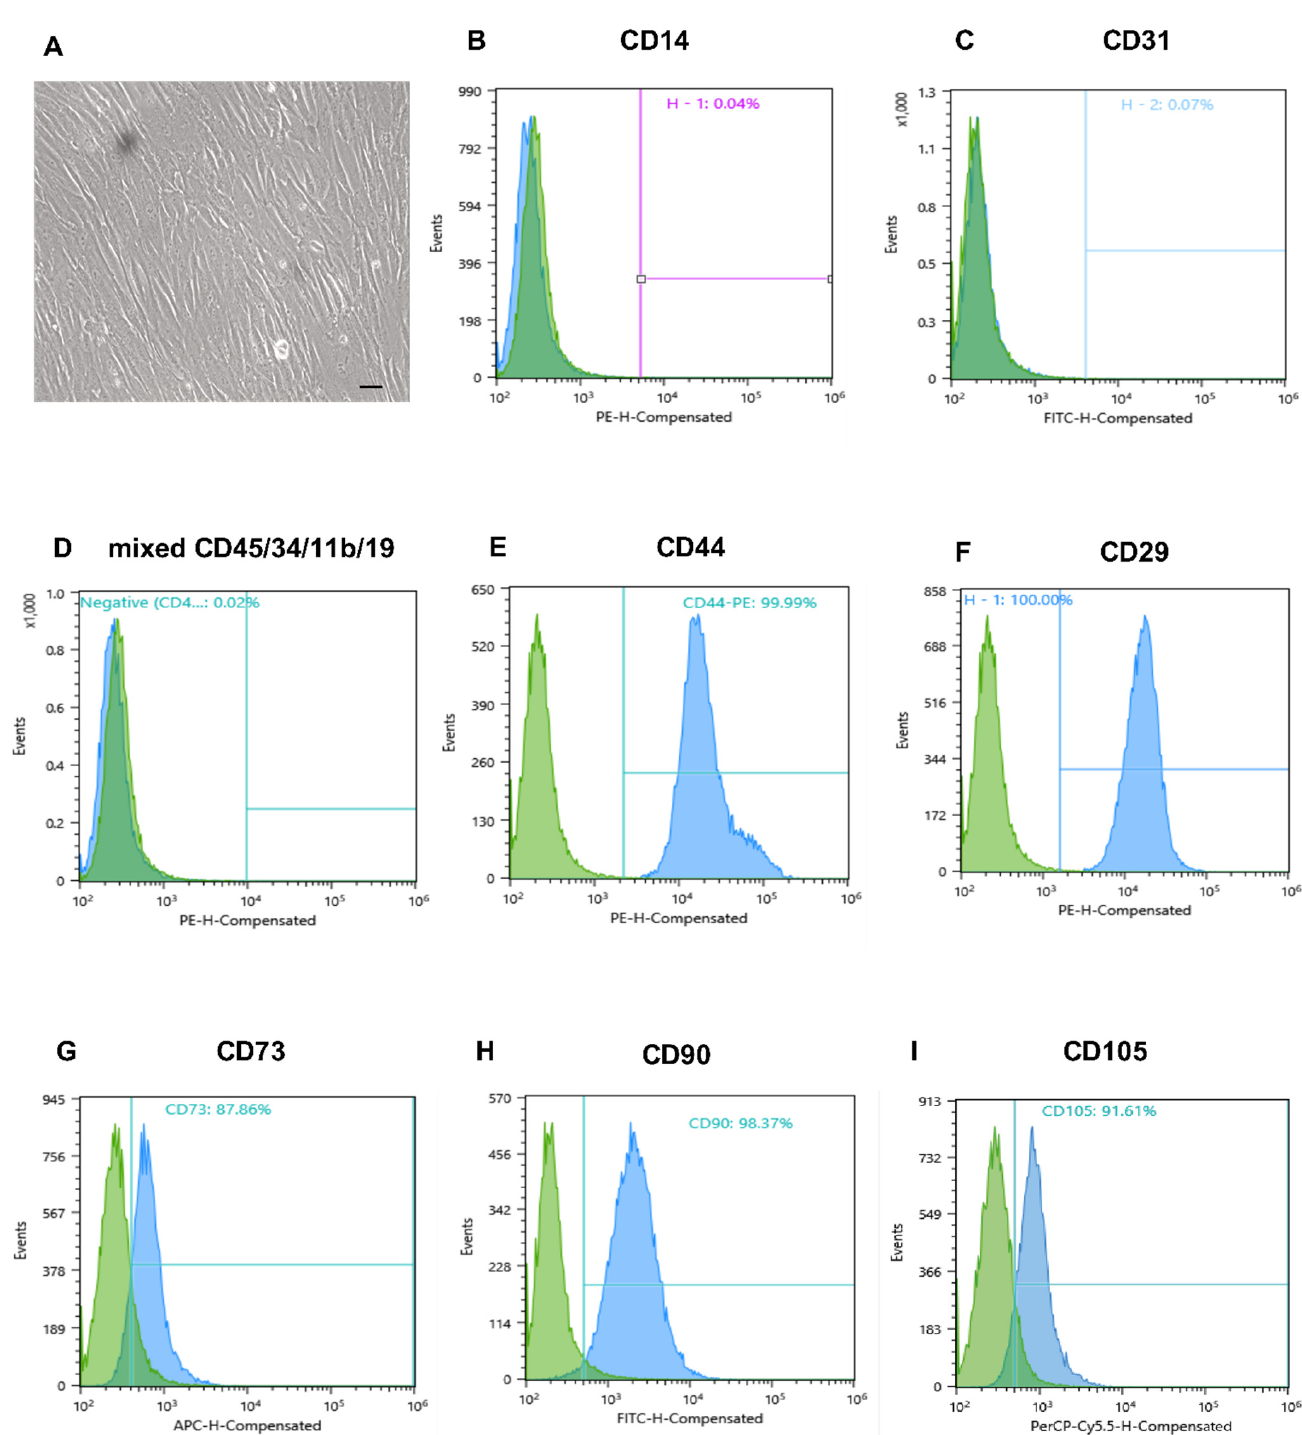
Figure 1. Morphology of placental MMSCs and flow cytometric analysis of specific markers of MSCs. ( A ) Third-passage MMSCs on day 3 in monolayer culture. Phase contrast microscopy, scale bars 100 µ m. ( B – D ) Negative endothelial and blood cell marker expression. ( E – I ) High expression of surface marker characteristic of MMSC population. MMSC, multipotent mesenchymal stromal cell.